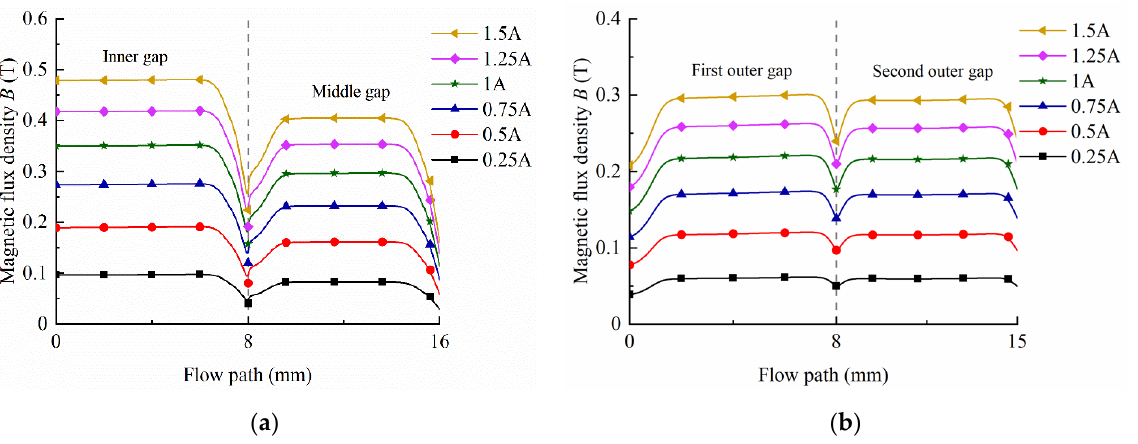
Figure 9. Magnetic flux density of the proposed MR damper at each gap with various current inputs: ( a ) Inner gap and middle gap; ( b ) First outer gap and Second outer gap.